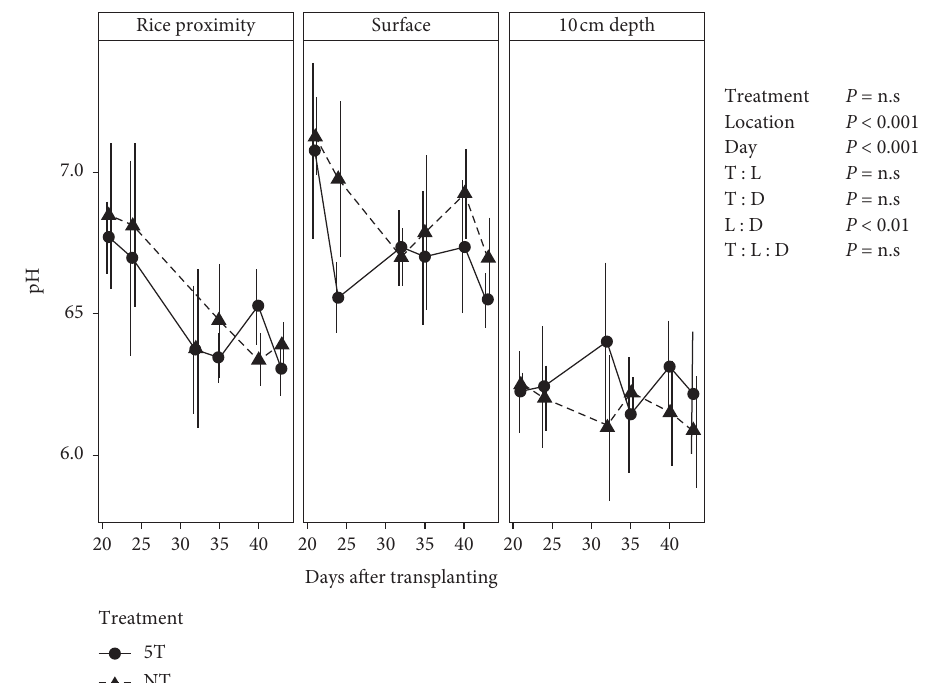
Figure 5: Change of soil pH after transplanting at location rice proximity, surface, and 10 cm depth under no tillage (NT) and 5 times tillage (5T) treatment. Level of significance was determined by three-way ANOVA. Error bars represent standard deviations ( n � 3).